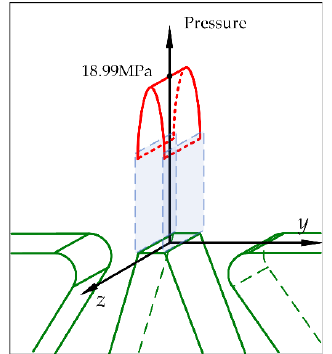
Figure 8. Pressure distribution on the solid impact surface. Assumption 8. On both sides of the stagnation point, the same amount of momentum in the jet direction is depleted by the shunt wedge and the receivers; that is, each side is faced with half of the total momentum of the deflector